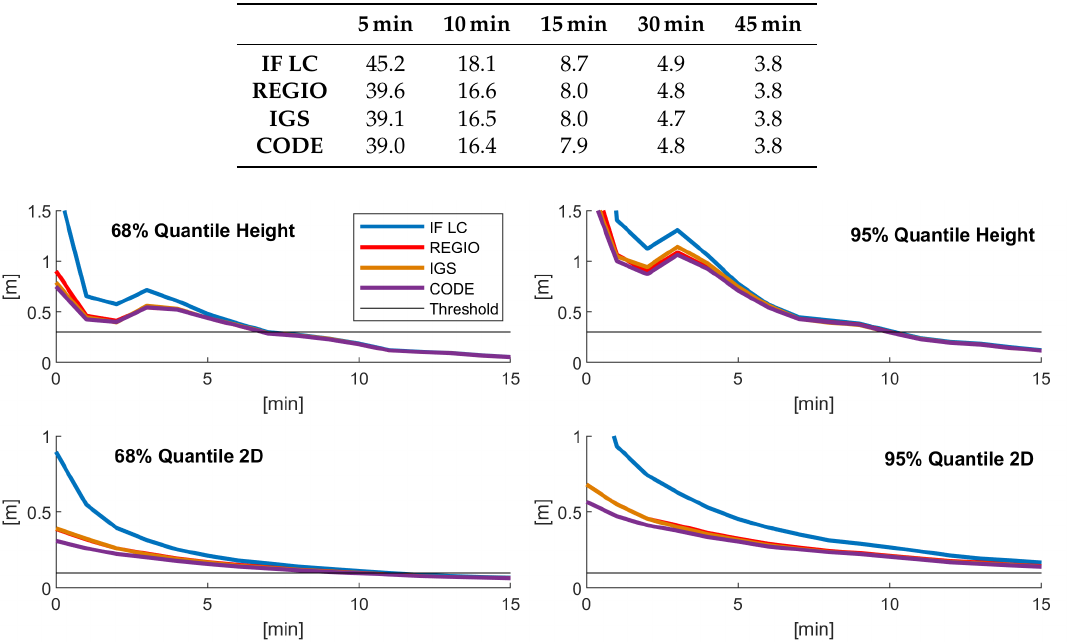
Figure 7. 68% ( left ) and 95% ( right ) quantiles of the coordinate error in the height component ( top ) and the horizontal position error ( bottom ) for the different PPP